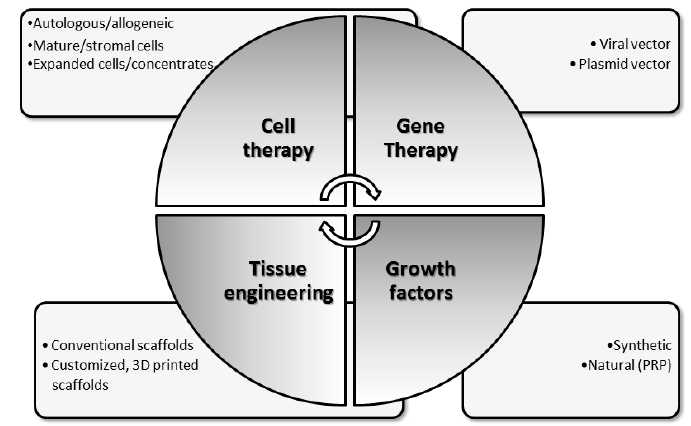
Figure 2. Graphical representation of regenerative medicine strategies utilized to treat OA. Clockwise from the upper left: cell therapy, i.e., injection, grafting or implantation of cells previously manipulated ex vivo or non-manipulated (concentrates); tissue engineering, relying on the use of scaffolds which act as a template for cell attachment and reproduce as closely as possible cartilage ECM and can be produced by conventional or additive manufacturing procedures; growth factors, synthetic on naturals, to be used as adjuvants to favor tissue regeneration; gene therapy, with the aim to treat human diseases by correcting an existing abnormality or providing a new function by means of viral and non-viral (plasmids) vectors.